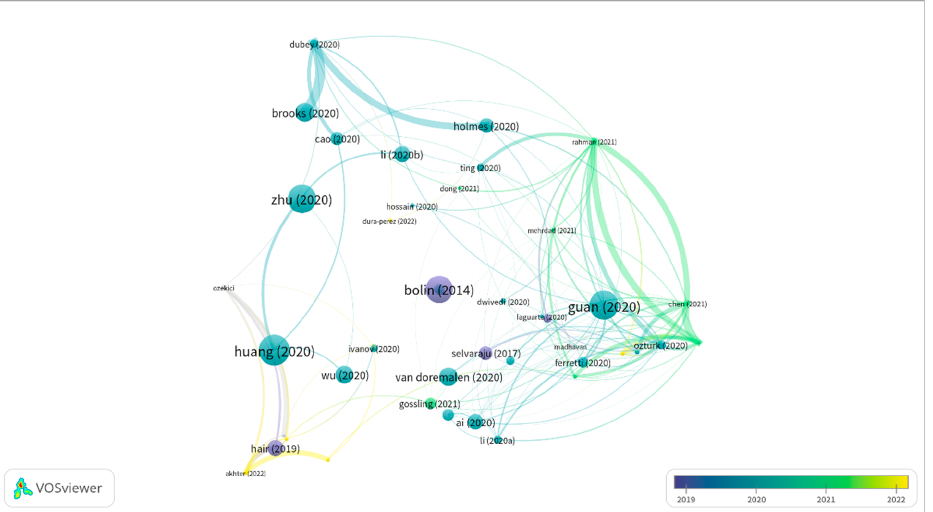
Figure 8. Bibliographic coupling analysis of core articles based on VOSviewer. Representative arti- cles [18–30,32–39,41,42,44–69] were included. Different colors in the figure represent the publishing years of literature nodes, and the thickness of the link indicates the coupling relationship between the nodes, which means that a thicker link reflects that these two articles have more mutual refer- ences. Node size means the citation frequency and also the weight in the network.